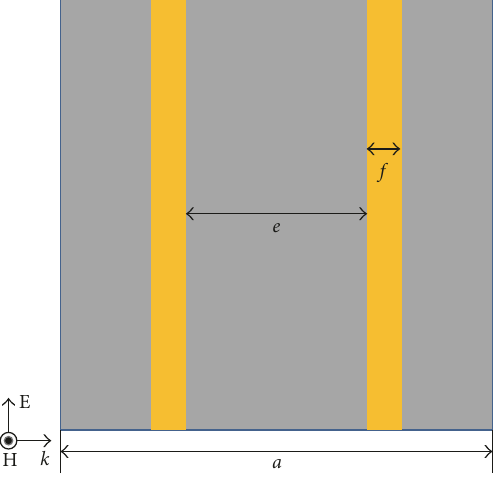
Figure 10: Geometry of the metallic wires printed on the other side of the